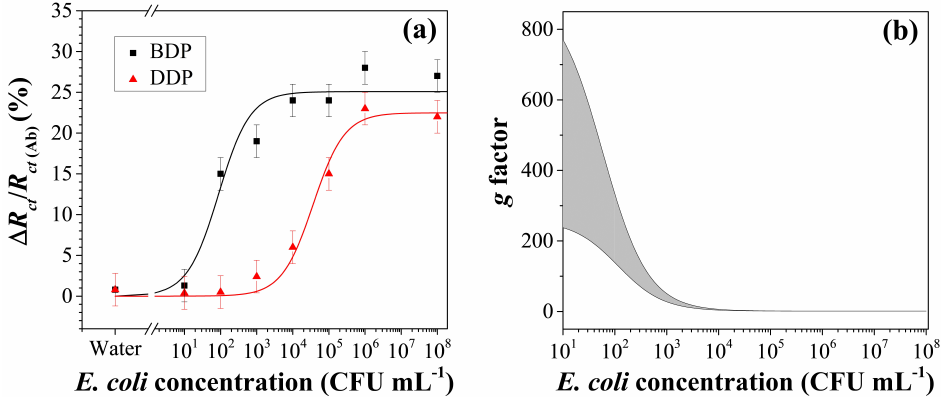
Figure 7. ( a ) Dose-response curve obtained using both protocols: DDP–direct detection protocol and BDP–ballasting detection protocol. The experimental data are fitted by Equation (6); ( b ) Gain factor g as a function of the E. coli